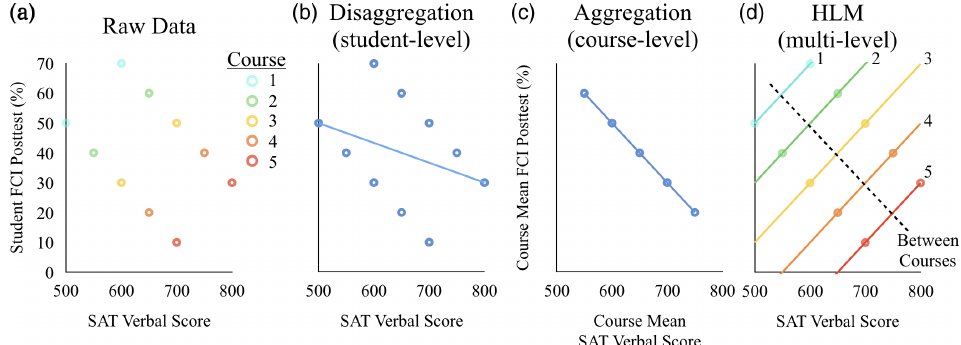
FIG. 1. Example dataset of the relationships between SAT verbal and Force Concept Inventory (FCI) post-test scores analyzed using 4 different methods. (a) A plot of the raw data without any model. (b) Disaggregation, which ignores any course groupings and analyzes all of the student-level data. (c) Aggregation, which averages student-level data to create course-level data and then analyzes them. (d) Hierarchical linear modeling (HLM), which analyzes student- and course-level data simultaneously. We adapted the figure from an example in Snijders and Bosker [22] and Woltman et al.